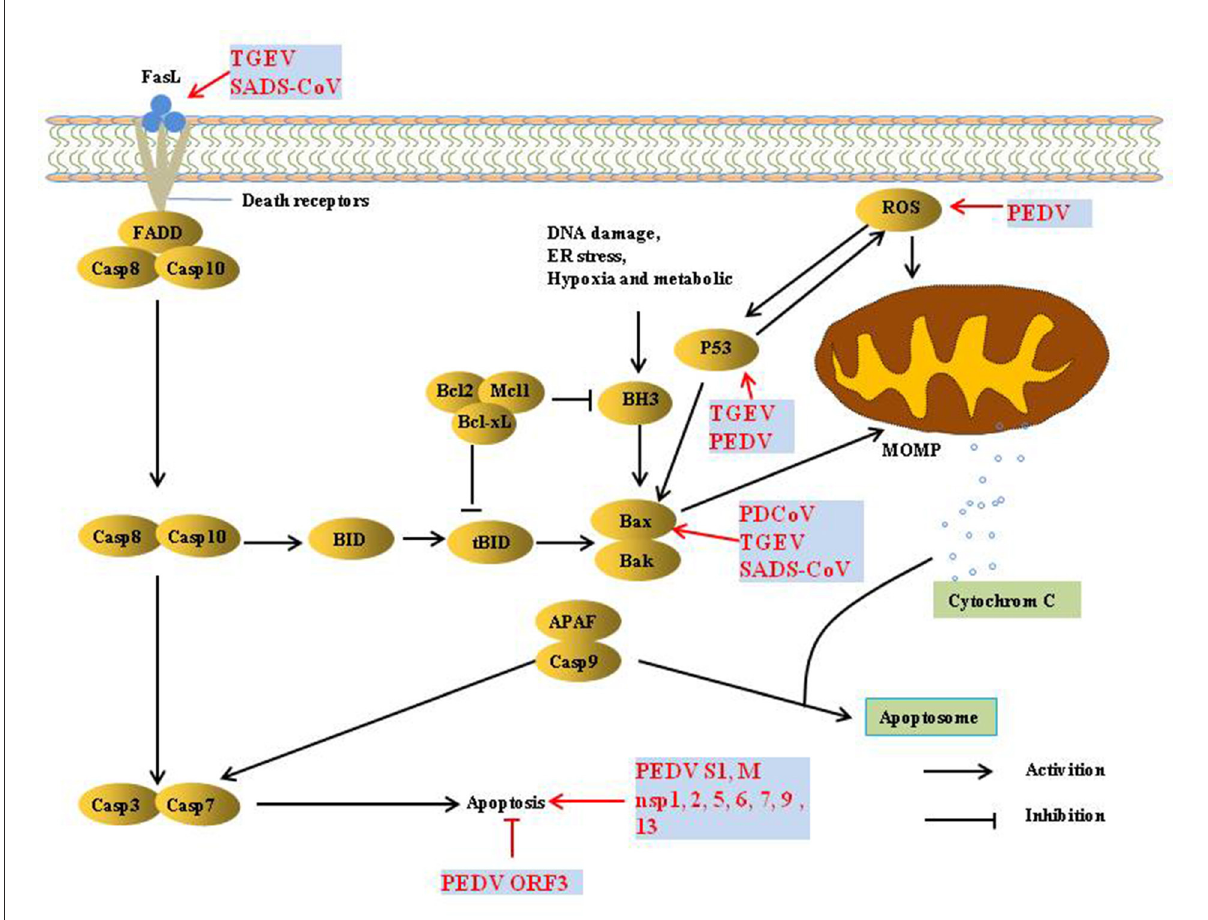
FIGURE3 Induction and modulation of host apoptosis by SeCoV